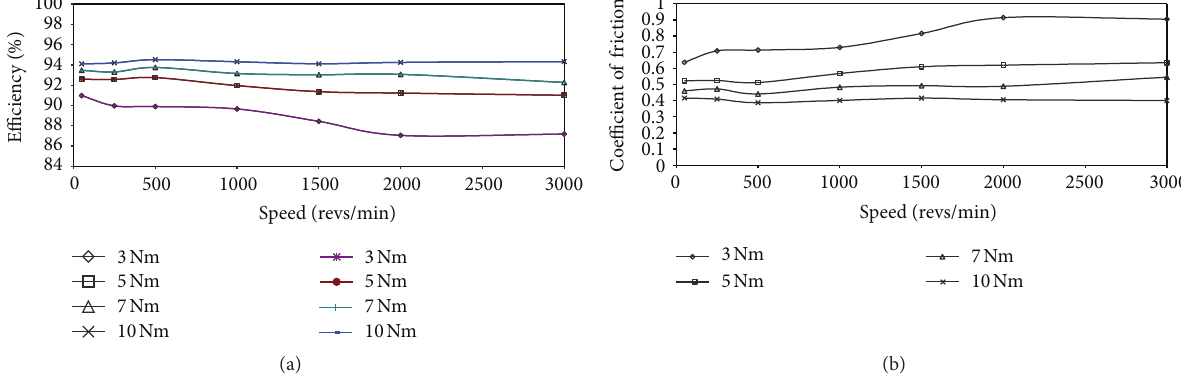
F 10: Showing (a) the efficiency and (b) the derived coefficients of friction for 30